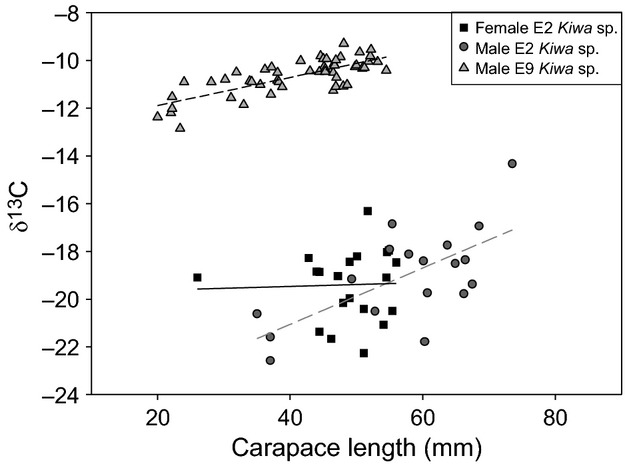
Plots of δ13C against carapace length (mm) for Kiwa sp. nov. East Scotia Ridge (ESR) for samples collected from E2 female (squares and solid line), E2 male (circles and long dash line), and E9 male (triangles and short dash line) Kiwa. In male Kiwa sp. nov. ESR there was an increase in δ13C with carapace length (mm) (CL) in E2 (δ13C = −25.78 + 0.118 CL; F1,16 = 12.93, r2adj = 0.41, P < 0.01) and E9 (δ13C = −13.06 + 0.059 CL; F1,50 = 67.81, r2adj = 0.58, P < 0.001). However, female Kiwa sp. nov. ESR did not increase in δ13C with CL (δ13C = −21.52 + 0.118 CL; F1,17 = 0.2428, r2adj = −0.04, P = 0.69).